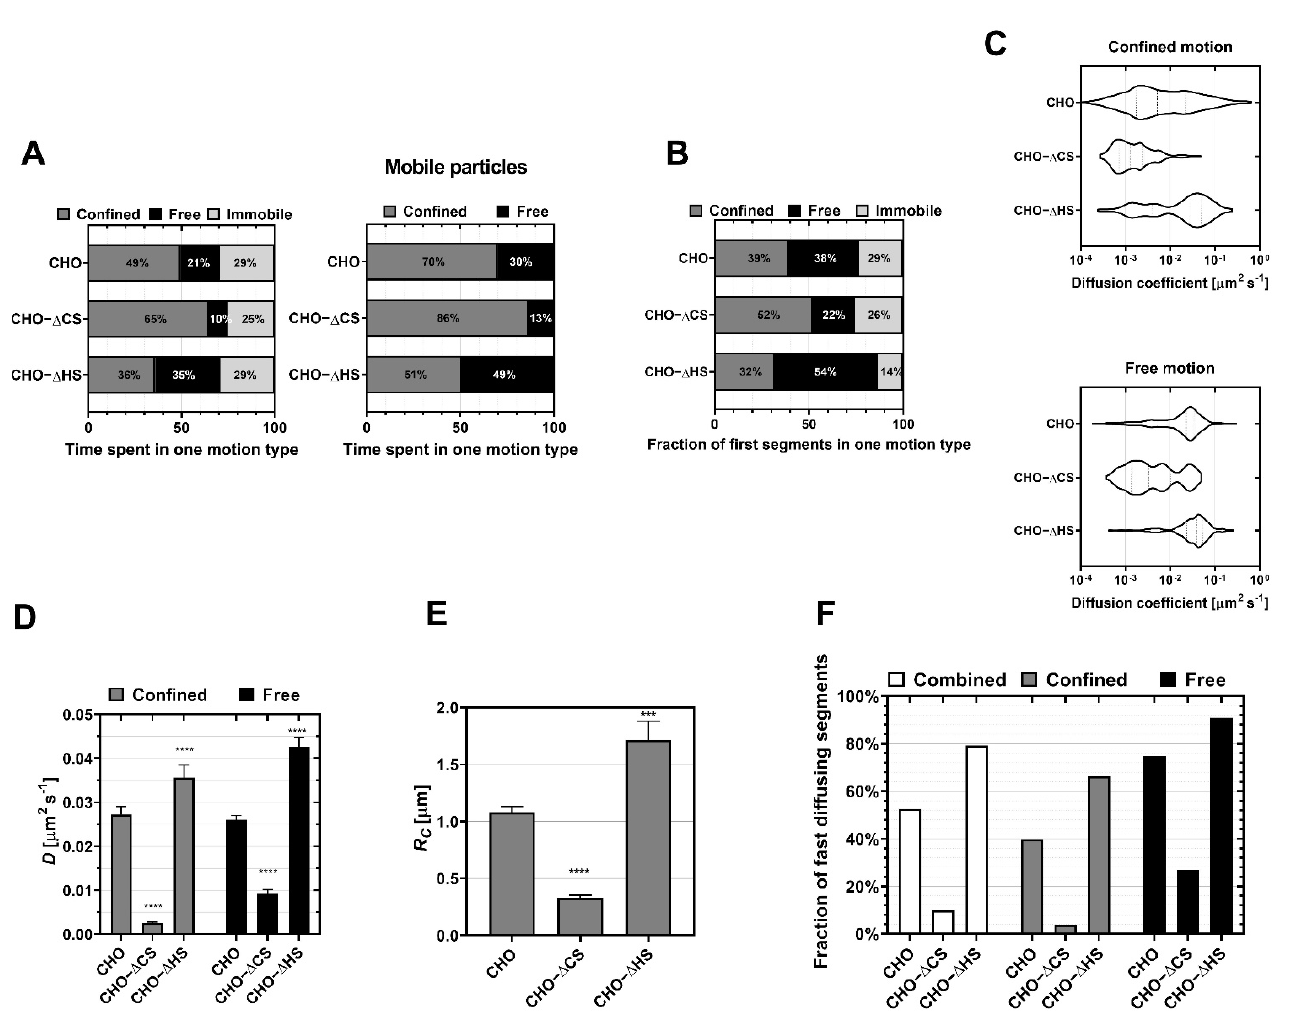
Figure 2. Influence of the nature of the glycosaminoglycans on the initial diffusion of HSV-1 at the surface of non-susceptible CHO-K1 cells. HSV-1 (KOS) diffusion is recorded on CHO-K1 cells expressing both heparan sulfate (HS) and chondroitin sulfate (CS) (CHO), CHO treated with ChABC (CHO- ∆ CS) and pgsD-677 cells lacking HS (CHO- ∆ HS). ( A ) The fraction of the total time spent by KOS particles in one of the motion types. Left: confined (grey), free (black) and immobile (light gray); Right: mobile particles only (confined (grey) and free (black)). ( B ) The fraction of first segments in one of the three motion types. ( C ) Distributions of the diffusion coefficients plotted in violin plots show two populations: slow and fast particles, classified according to a cutoff of 10 − 2 µ m 2 .s − 1 . ( D ) The mean of the diffusion coefficient D of the full distribution presented in ( C ). ( E ) The confinement radius R C of the confined motion for the different cases. ( F ) The fraction of particles exhibiting fast diffusion are presented for the confined and free diffusion combined (white), and for each separated motion type. The total number of viruses used here is 644, 204 and 176 for CHO, CHO- ∆ CS, CHO- ∆ HS, respectively. The data were acquired in at least three independent experiments. Asterisks denote a significant difference by Welch t -test: *** p ≤ 0.001 and **** p ≤ 0.0001 relative to control. The percentage of fraction ( A , B ) is obtained from counting, so no statistical analysis is